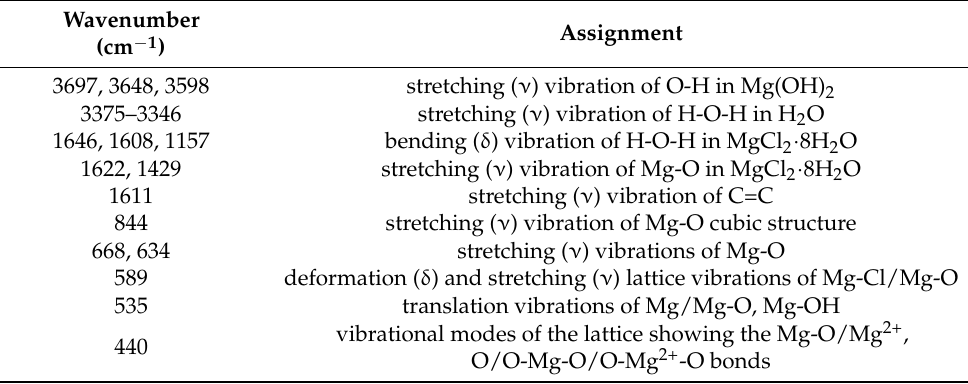
Table 2. Assignments of the major absorption bands of MOC composites.